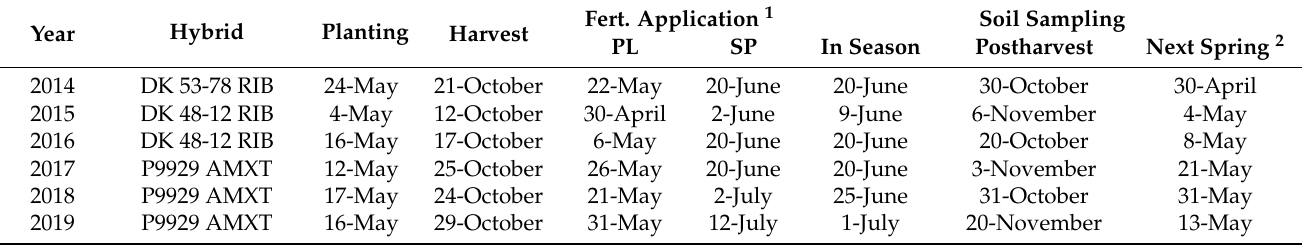
Table 2. Corn hybrid, and dates for planting, harvest, fertilizer application and soil sampling from 2014 to